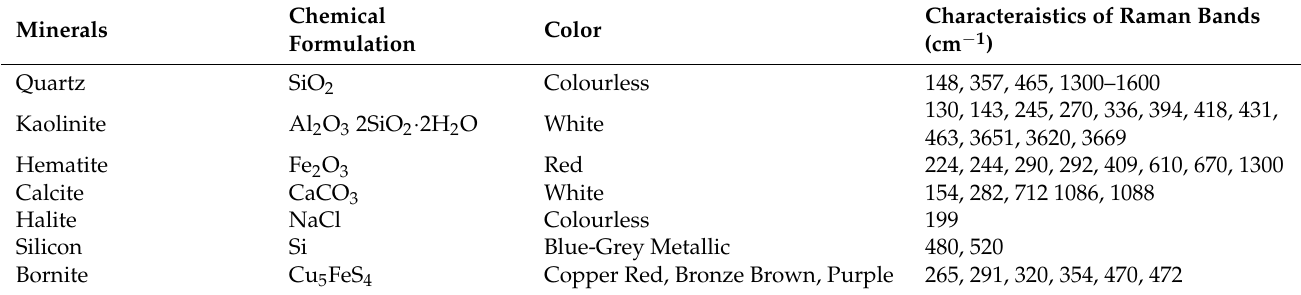
Figure 6. Raman spectra of hydrate-bearing sediment samples. Table 7. Mineralogical and chemical properties of sediment samples [53] with permission from Elsevier, 2000.